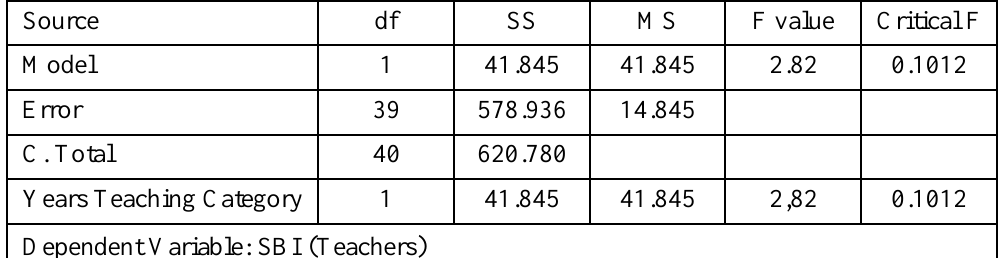
Table 1: Analysis of Variance Procedure for the Null Hypothesis